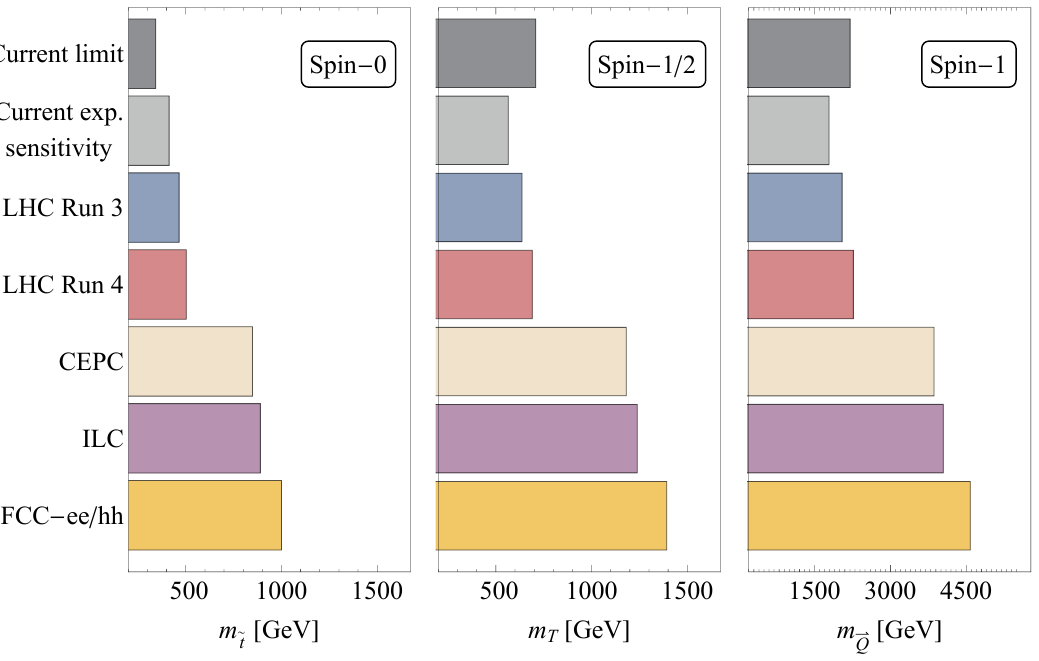
Figure 4 . Excluded parameter space and expected sensitivities at the 2 (cid:27) CL of current and future data for spin-0 (left), spin-1/2 (middle), and spin-1 (right) top-partners. We assume that (cid:17) m the two spin-0 top partners are degenerate in mass, m ~ = m ~ ~ t . We assume that top partners t 1 t 2 contribute only in the hgg and h(cid:13)(cid:13) loops, there are no modi(cid:12)cations of the Higgs couplings to other SM particles, and there are no exotic or invisible Higgs decays. The parameter space excluded by current LHC and Tevatron data is shown in dark gray, while the expected sensitivity of the current data is shown in light gray. Future LHC runs and the proposed future colliders (ILC, CEPC, and FCC-ee/hh) are shown in various